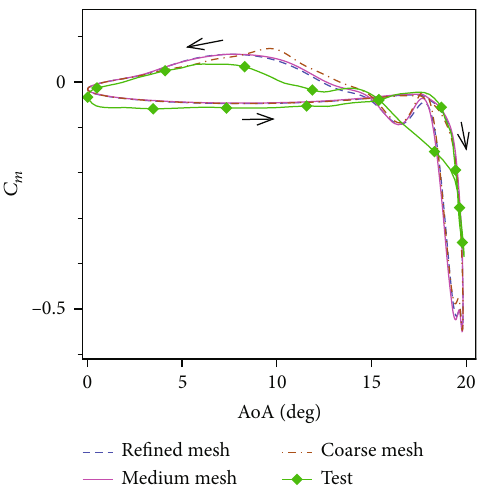
Figure 7: Comparison of pitching moment coe ffi cients between the numerical and test data.